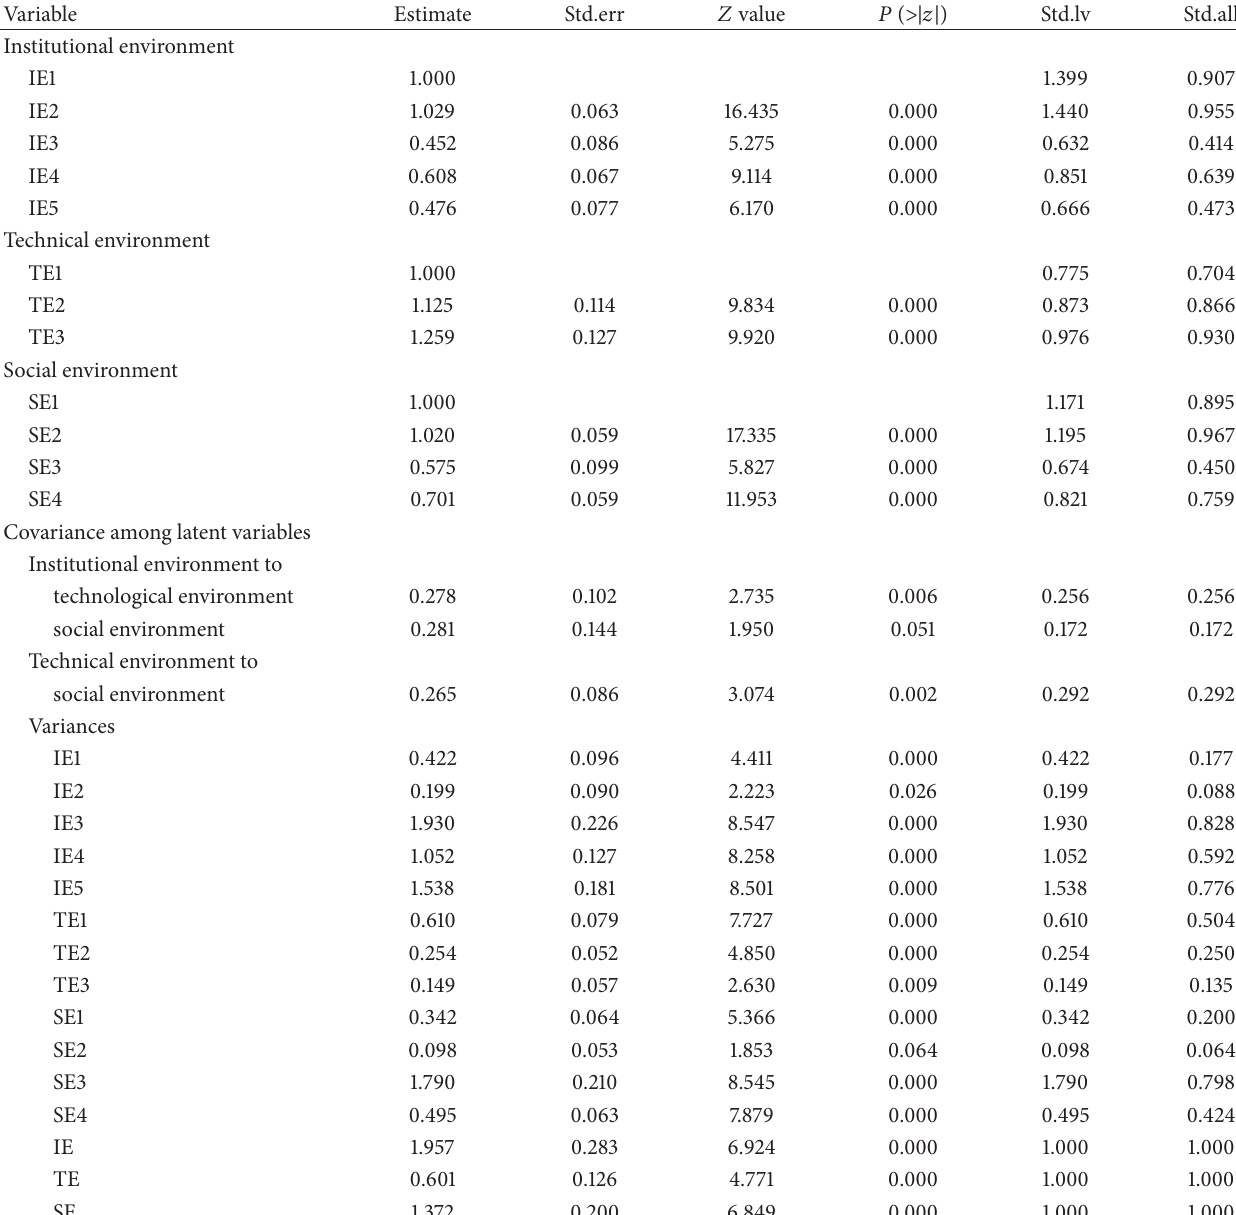
Table 4: Confirmatory factor analysis results for Nigeria on the institutional, technical, and social environmental variables relationship.